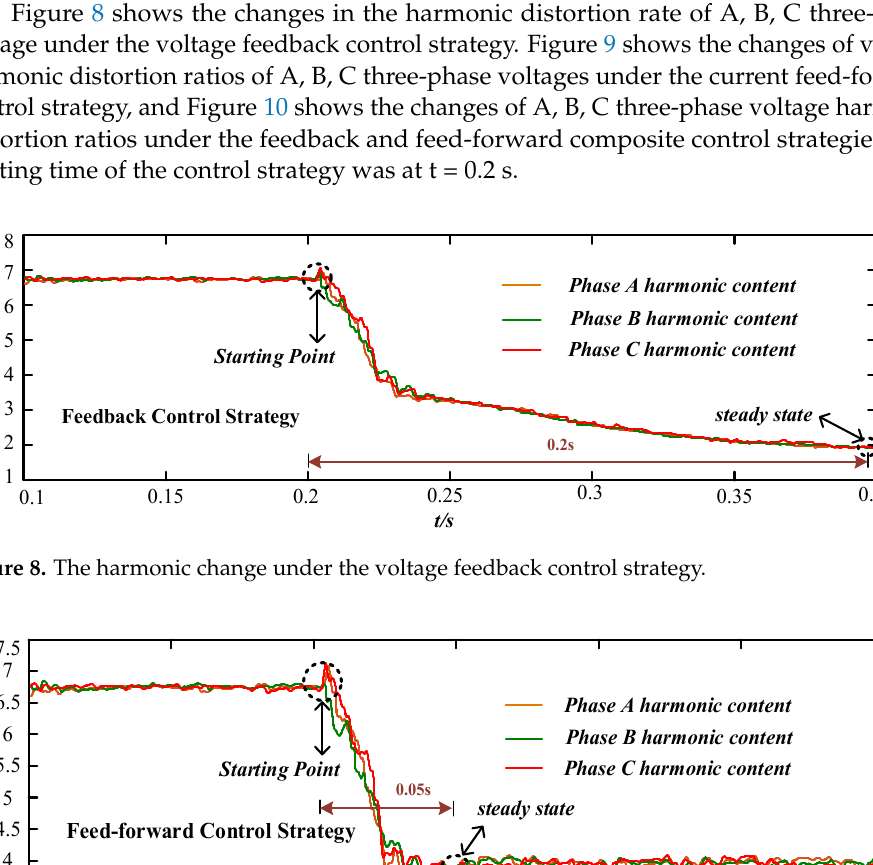
Figure 10. The harmonic change under the compound control strategy of feedback + feed-forward.